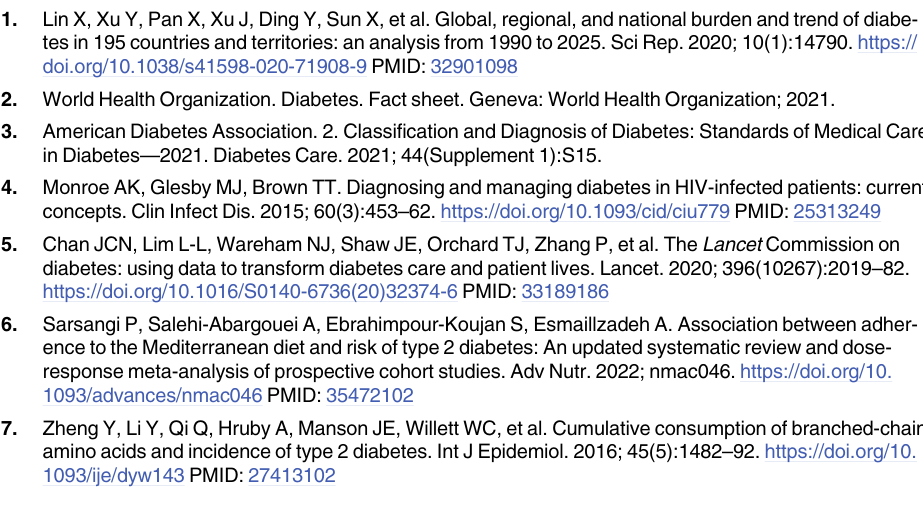
S1 Table. Definitions of cases and